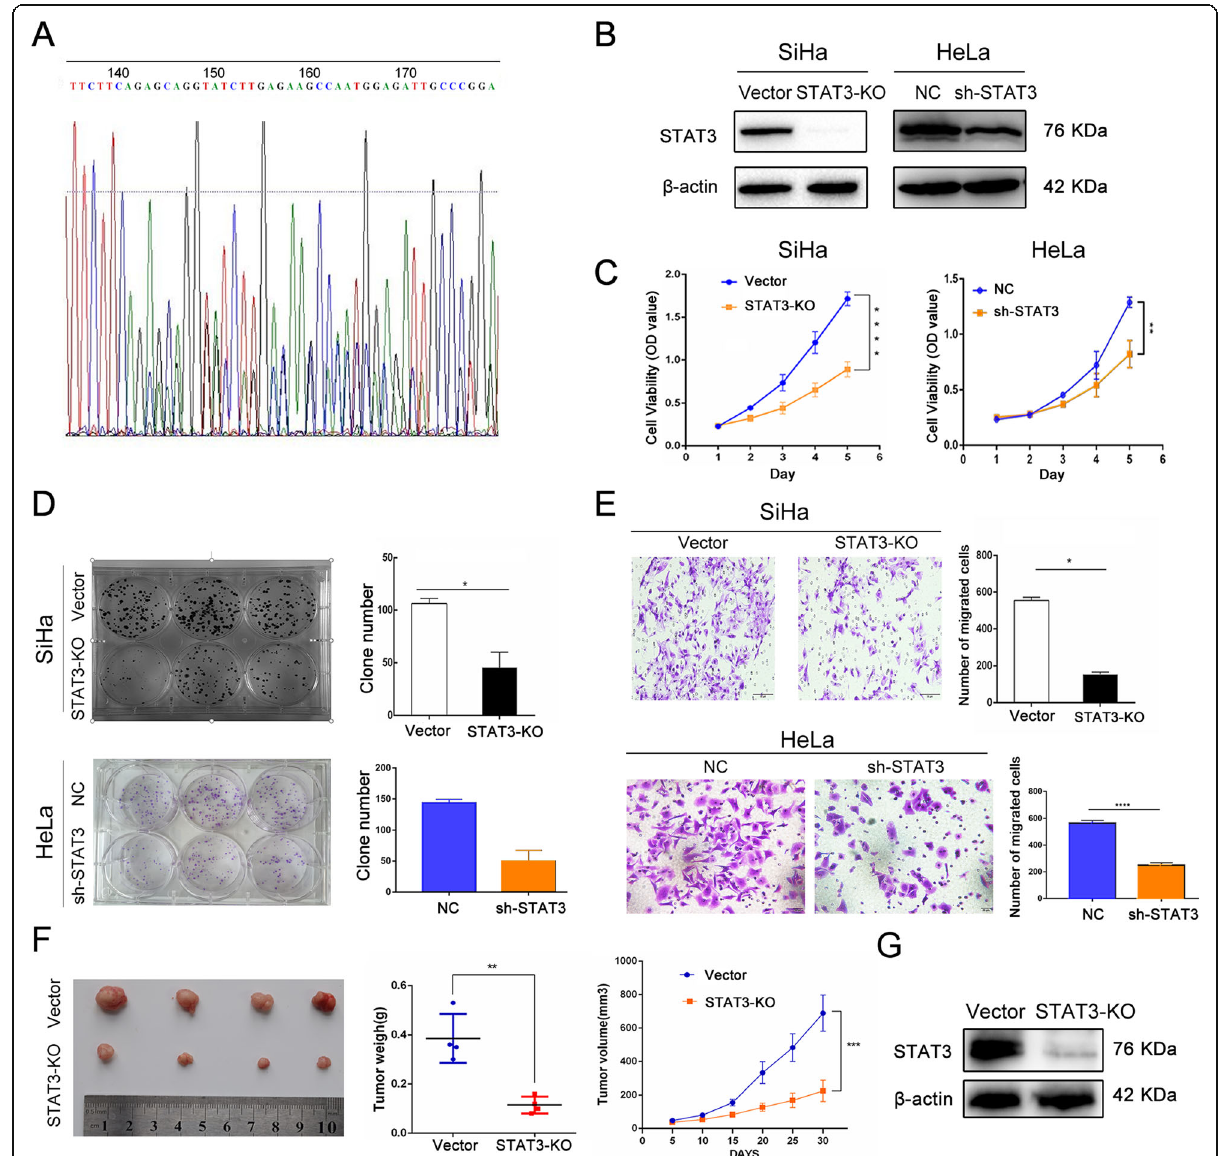
Fig. 2 STAT3 promotes proliferation, migration and clonal formation of cervical cancer cells. A STAT3 guide-RNA sequence; B The knockout and knockdown efficiency was verified by western blotting; C - E . cck8, clone formation, transwell assays detected the proliferation ability, clone formation and migration ability; F Representative appearance of subcutaneous tumors, the tumor weight and the tumor growth curve in the study; G The expression of STAT3 in tumor tissues was detected by western blotting. ( “ ns ” no significance, “ * ” p <0.05, “ ** ” p <0.01, “ *** ” p < 0.001, “ **** ” p